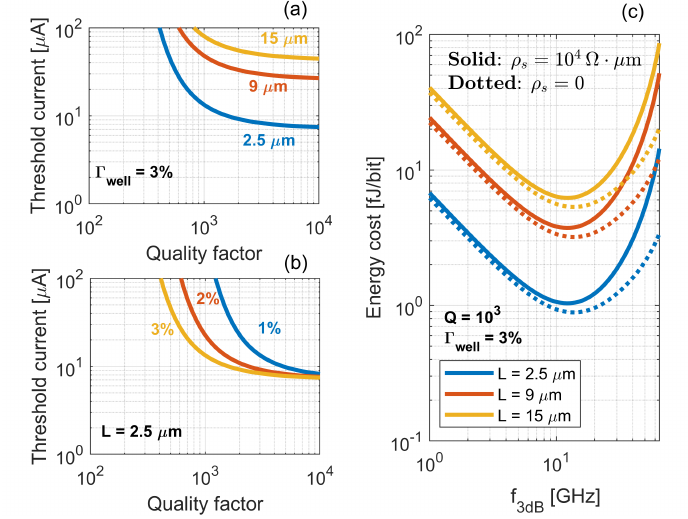
Figure 5. Threshold current versus Q-factor for different values of ( a ) the cavity length, L , and ( b ) confinement factor of a single active layer, Γ well . In ( a ), Γ well is 3%, and in ( b ) L is 2.5 µ m. ( c ) Energy cost versus 3dB direct modulation bandwidth, with line colors corresponding to different cavity lengths. The electrical resistivity, ρ s , is 10 4 Ω × µ m (solid) and 0 (dotted). The Q-factor is Q = 10 3 and the confinement factor of a single active layer Γ well =